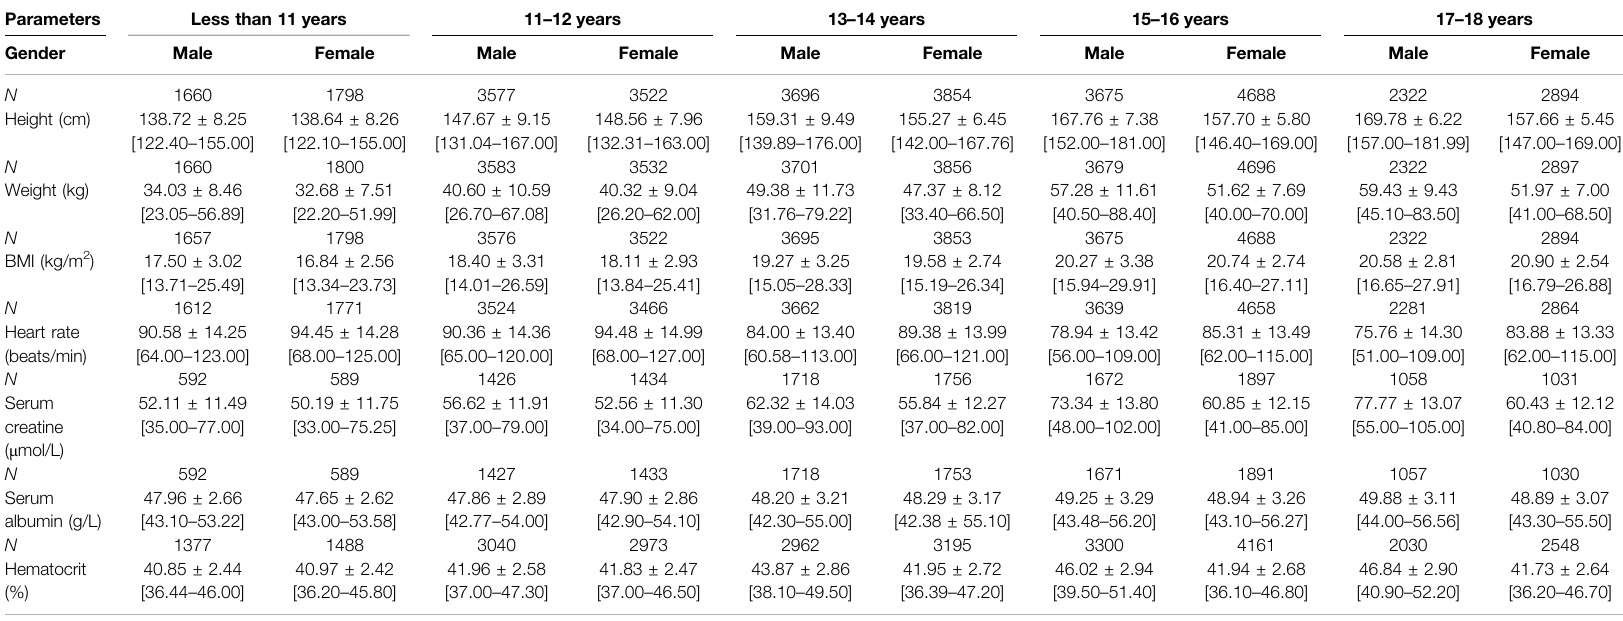
TABLE 3 | Summary of anthropometry data and hematological indexes in Chinese pediatric population a .